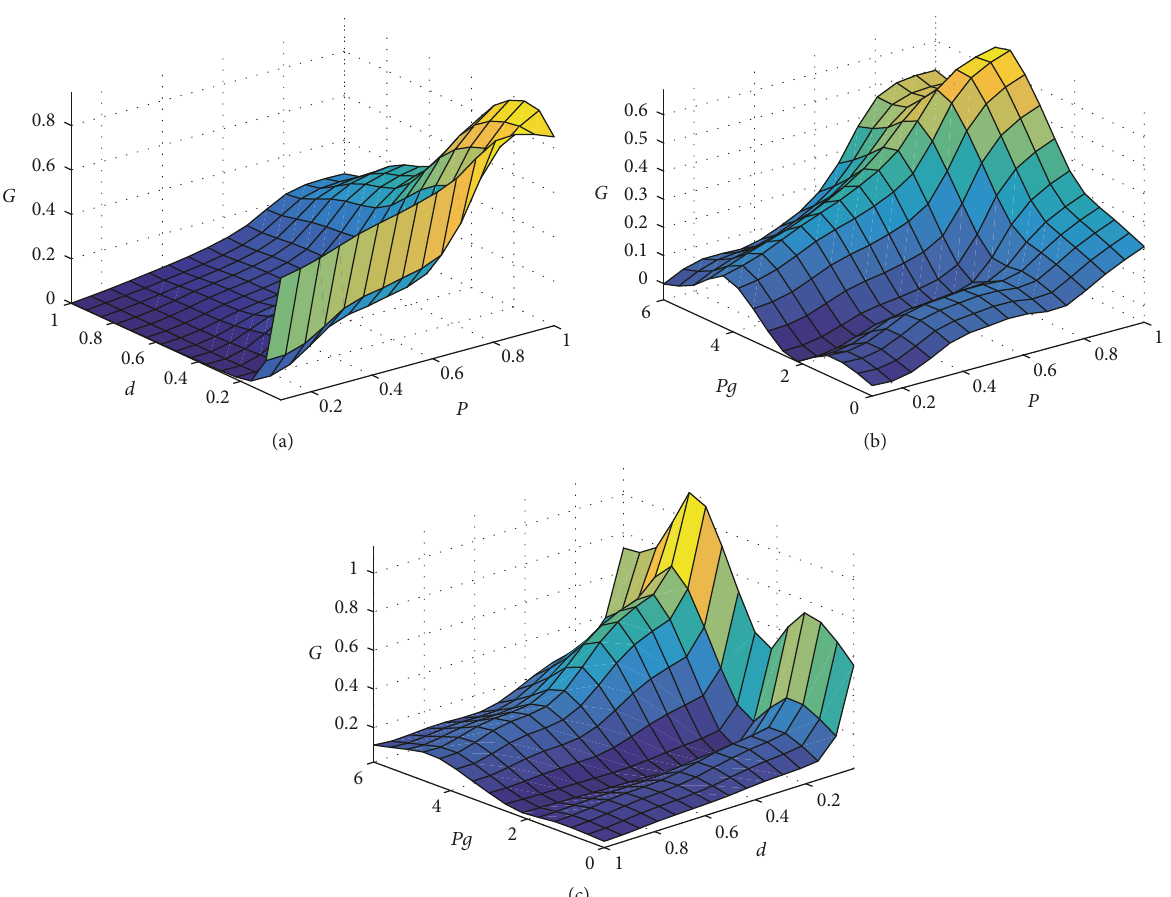
Figure 9: ANFIS fuzzy output surfaces: 𝑃 - 𝑑 , 𝑃 - 𝑃𝑔 , and 𝑃𝑔 - 𝑑 , respectively, from